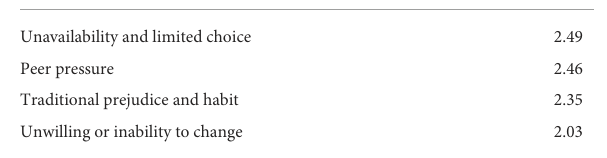
TABLE 9 Perceived barriers sorted by